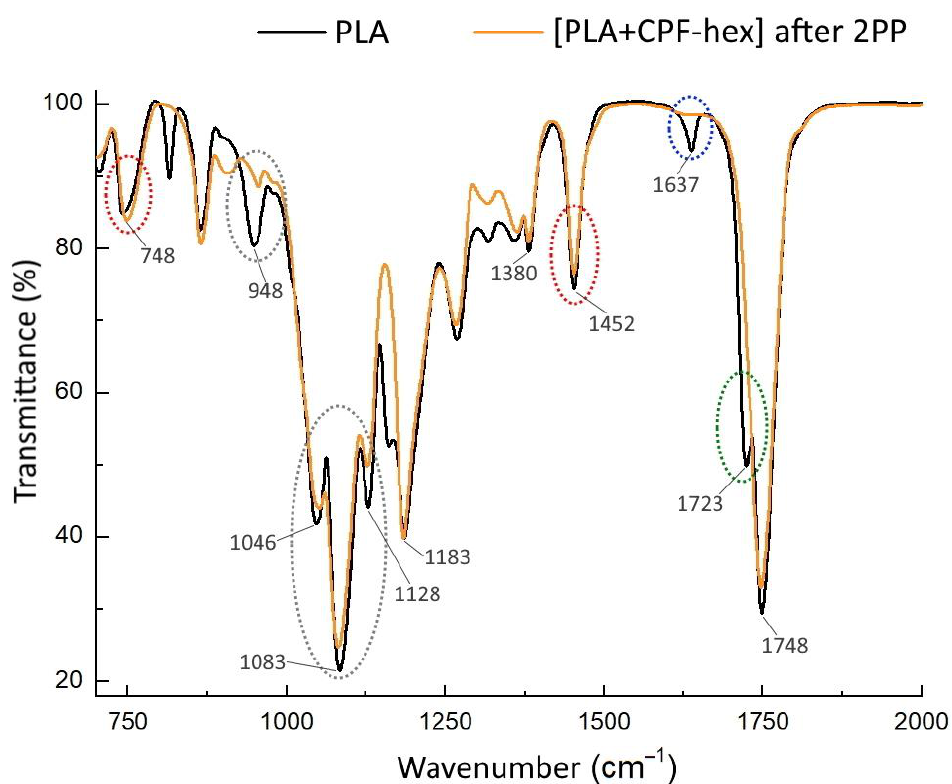
Figure 7. The IR spectra of the initial methacrylate-terminated star-shaped polylactide (PLA) and the polylactide-based resin after the 2PP processing ([PLA + CPF-hex] after 2PP).